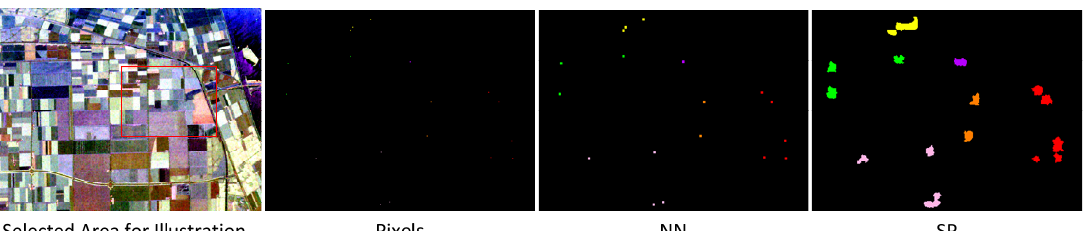
Figure 4. Example of the different training sets over a selected area (red box) based on contextual information (NN) and superpixel (SP)